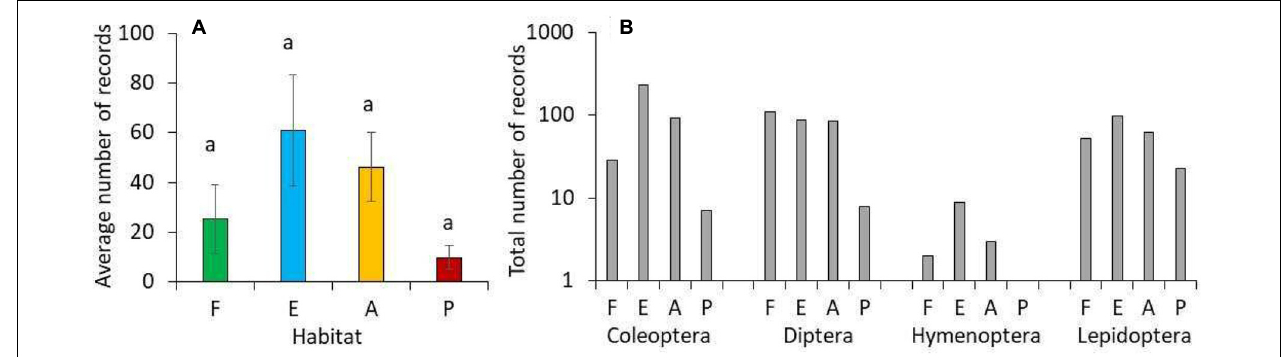
FIGURE 3 | (A) Average numbers of insects recorded in light traps in the forest (F, green), the forest edge (E, blue), the agricultural fields (A, orange), and the tree plantation (P, red). Identical letters in (A) above the error bars indicate lack of statistically significant differences in pair-wise U-tests after one-way Kruskal–Wallis ANOVA at P < 0.05. Error bars denote standard errors. (B) Respective numbers of four major insect orders.